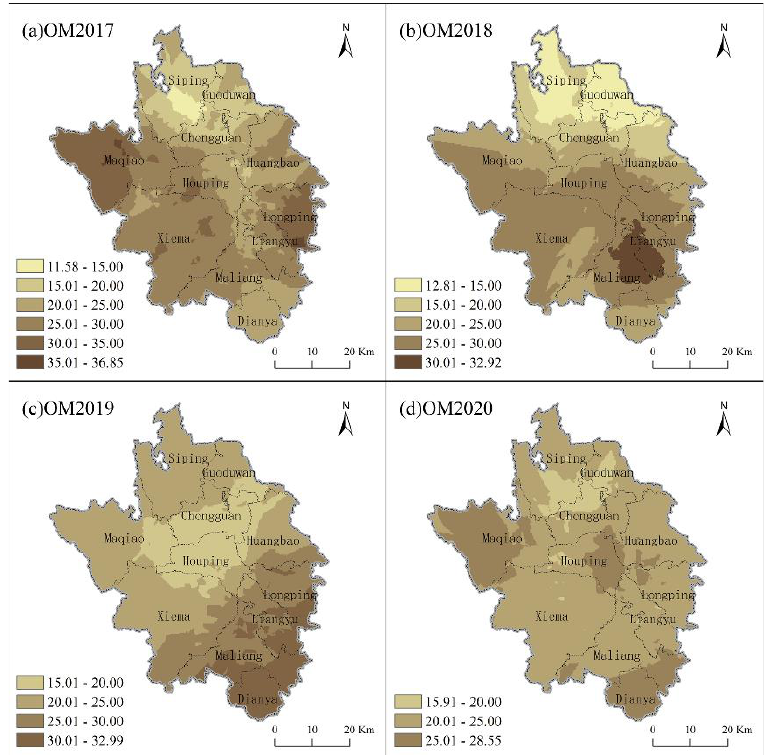
Figure 5. Ordinary kriging distribution maps for ( a ) 2017 OM, ( b ) 2018 OM, ( c ) 2019 OM and ( d ) 2020 OM.